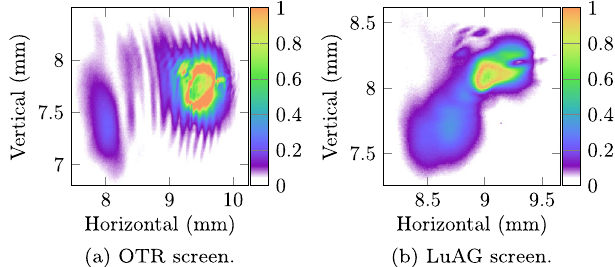
(a) OTR screen and (b) LuAG screen. For both images a long- pass filter, blocking wavelengths below 780 nm, was used.